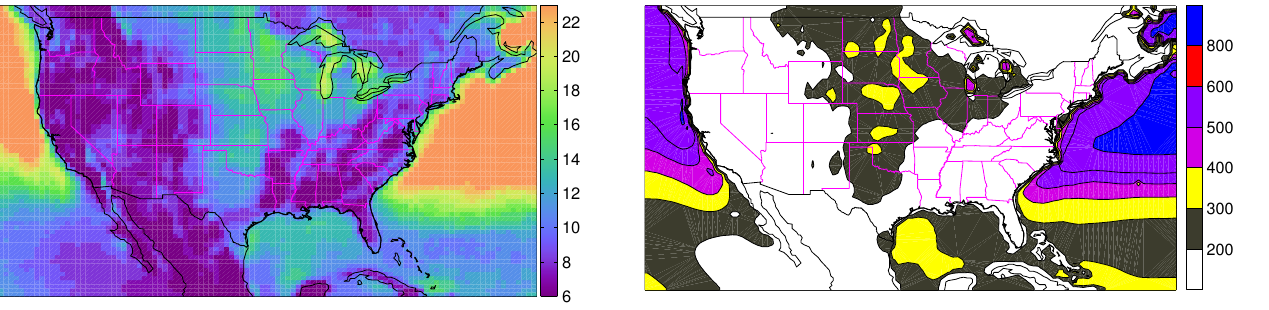
Fig. 6. Geographical variation of the median wind power episode length (h) across the US.